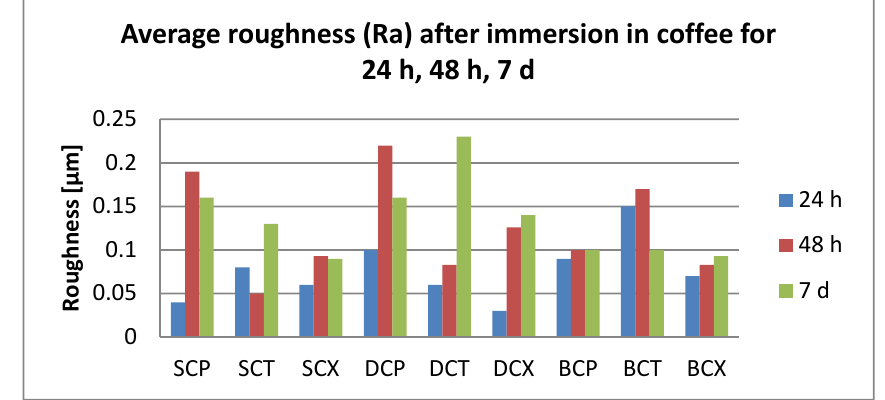
Figure 6. Mean values for average surface roughness (Ra) for the tested samples after immersion in coffee.